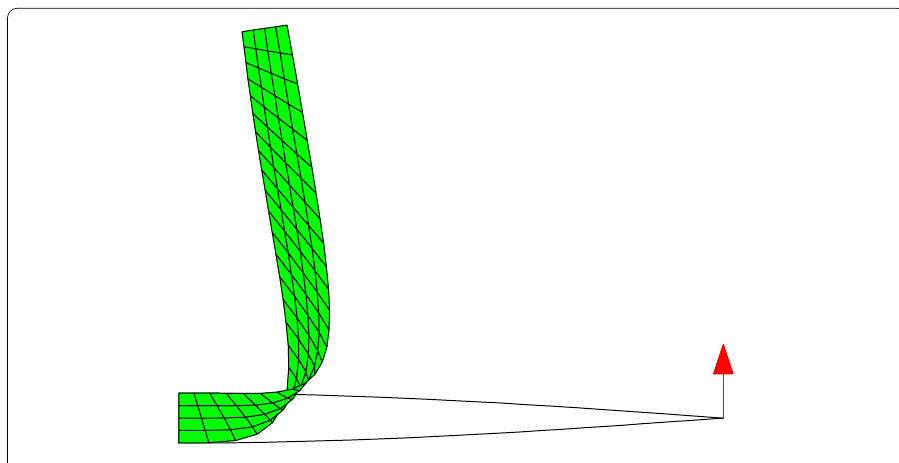
Fig. 23 Twisted beam: deformed beam using the distorted mesh 2 for P = 4 · 10 − 2